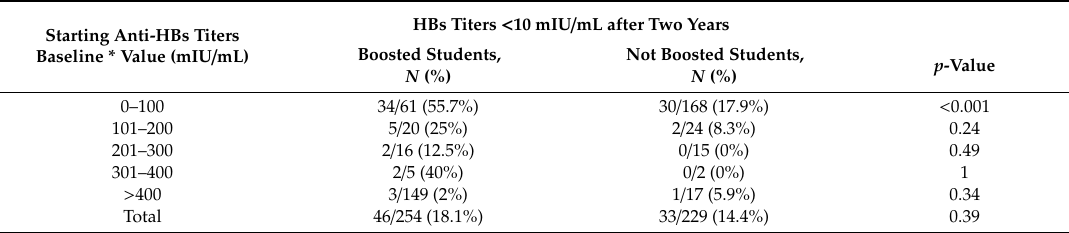
Table 2. Relative frequencies of students with hepatitis B surface antibody (anti-HBs) titers < 10 mIU / mL at 2-year follow-up visit, stratified according to their basal value and anti-hepatitis B virus (HBV) boostering. Starting Anti-HBs Titers Baseline * Value (mIU / mL)